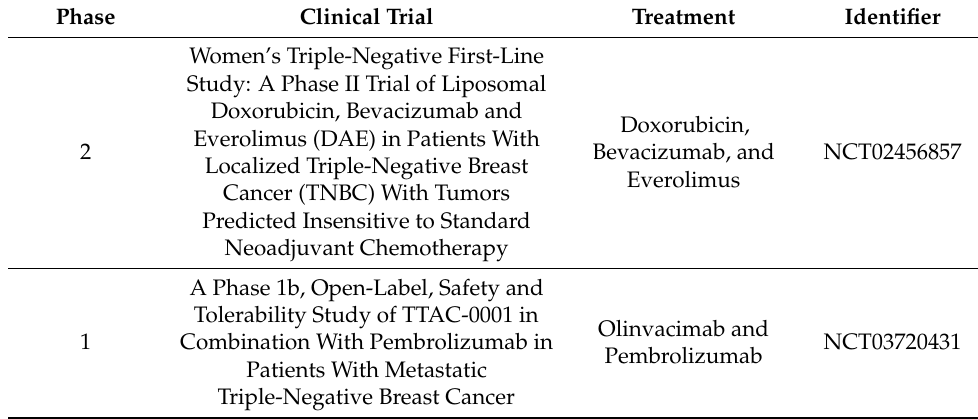
Table 3. List of active non-recruiting trials of combination therapy involving angiogenesis inhibitors in